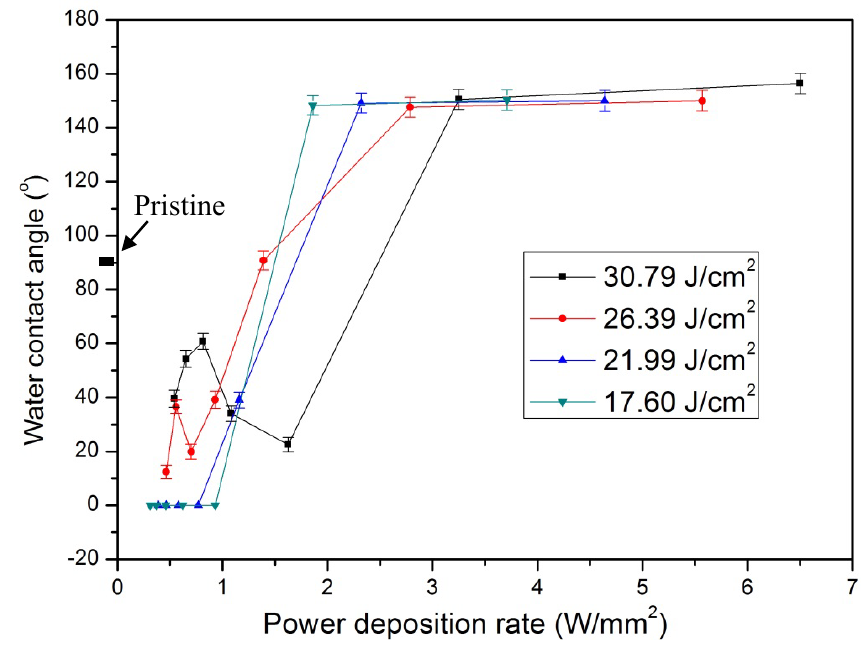
Figure 2. Effect of power deposition rate on water contact angle at different